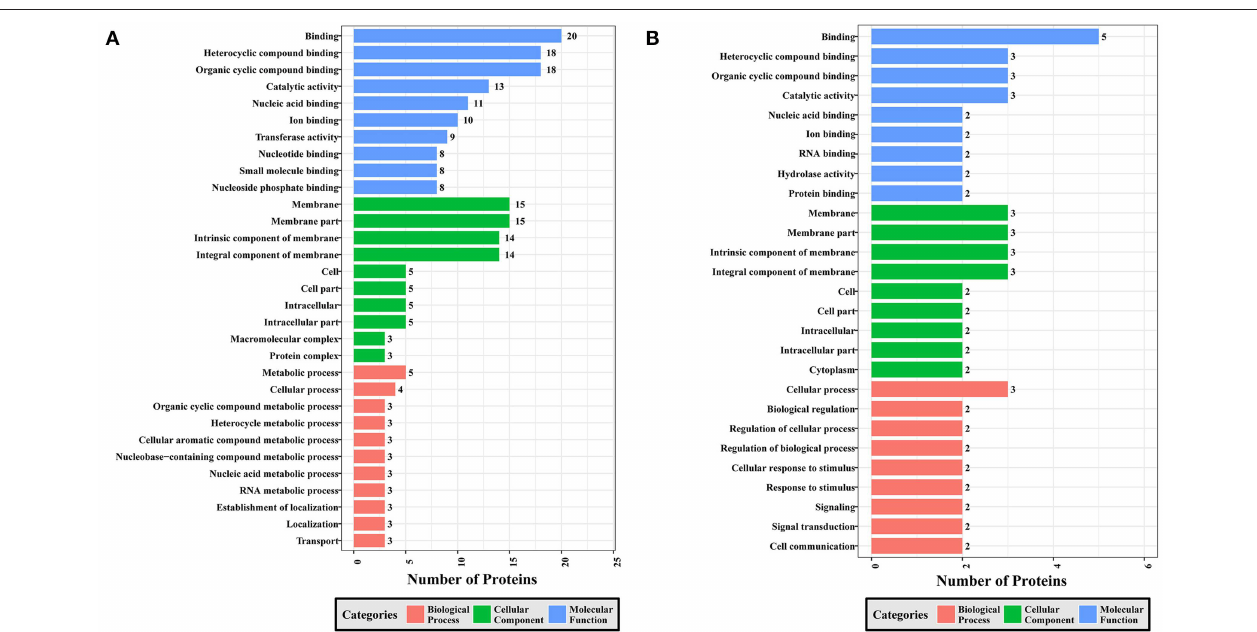
FIGURE 6 | GO analysis of phosphoproteins up/down-regulated in RH strain when comparing RH/PRU strains. The X-axis indicates the number of DEPs. The Y-axis represents GO terms of (A) upregulated and (B) downregulated phosphoproteins in RH strain when comparing RH/PRU strains, respectively.